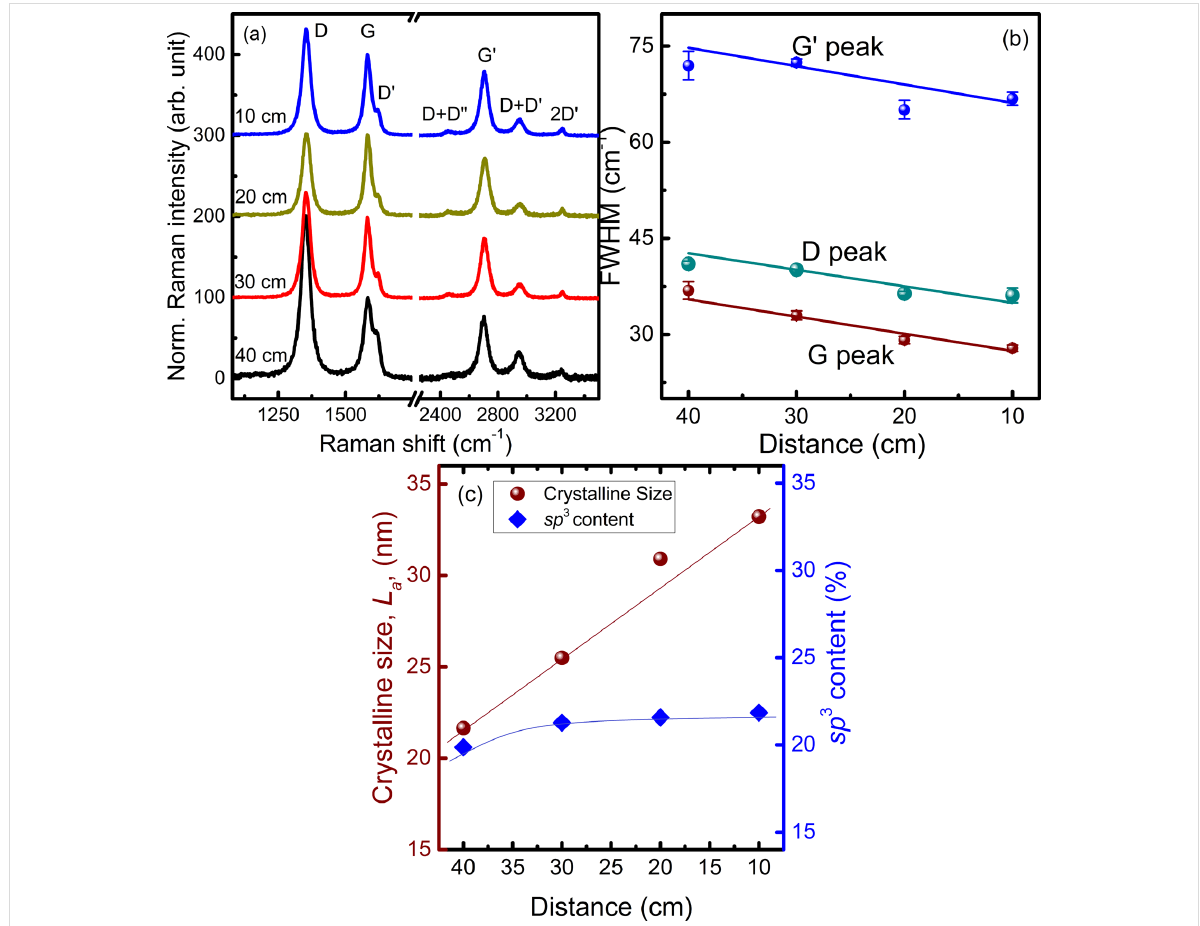
Figure 6: (a) Raman spectra of VGNs grown at different distance, (b) variation of FWHM of D, G, and G ′ band and (c) crystallite size and sp 3 content with respect to the distance from the plasma source to the substrate. Solid lines are to guide the eye.